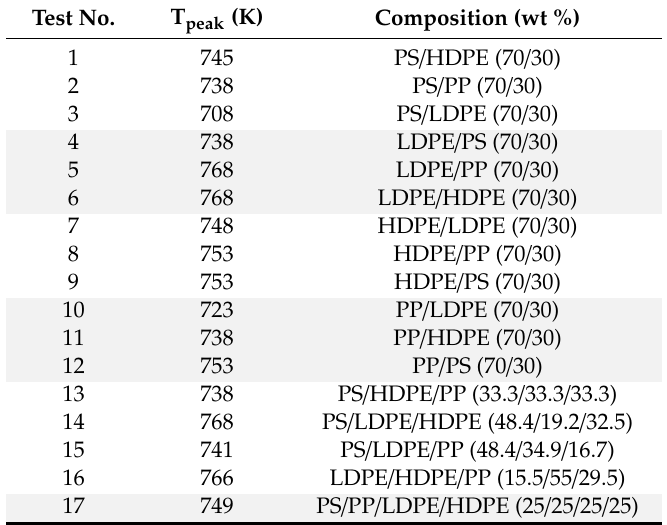
Table 5. Maximum decomposition temperature for di ff erent polymer blends at 60 K / min. Test